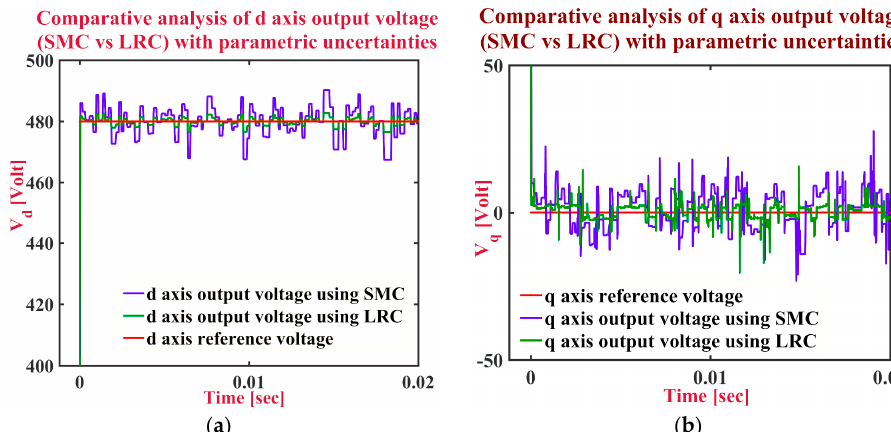
Figure 12. Comparison of performance between SMC (colored in blue) and LRC (colored in green) in case of ( a ) d -axis output voltage, ( b ) q -axis output voltage considering parametric uncertainties. LRC controller shows considerably better performance than SMC by staying closer to the reference